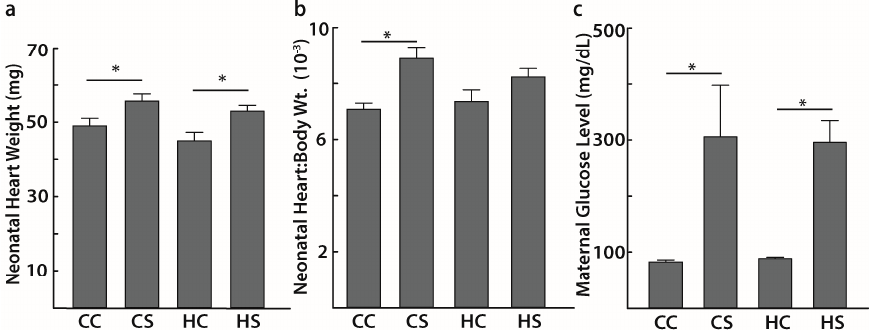
Figure 2. Physiological characteristics of pups and corresponding mothers. Higher neonatal heart weight ( a ) and neonatal heart to body weight ratio ( b ) that correspond to elevated maternal late gestation glucose levels ( c ) in diabetes exposed group; n = 10–12 ( a , b ), n = 2 ( c ). * p < 0.05, CC, controls; CS, diabetes exposed; HC, HF-diet exposed; HS, combination exposed.